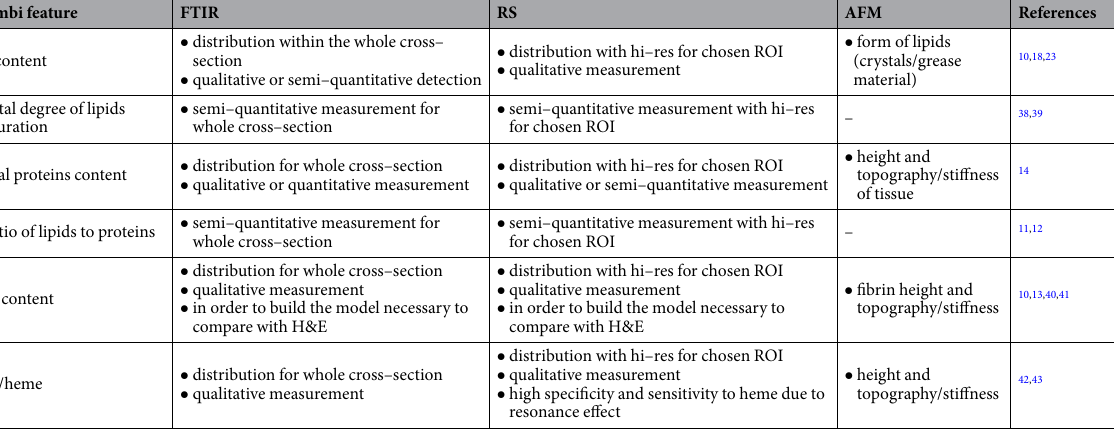
Table 1. The comparison of the analytical potential of FTIR, RS and AFM in the thrombi